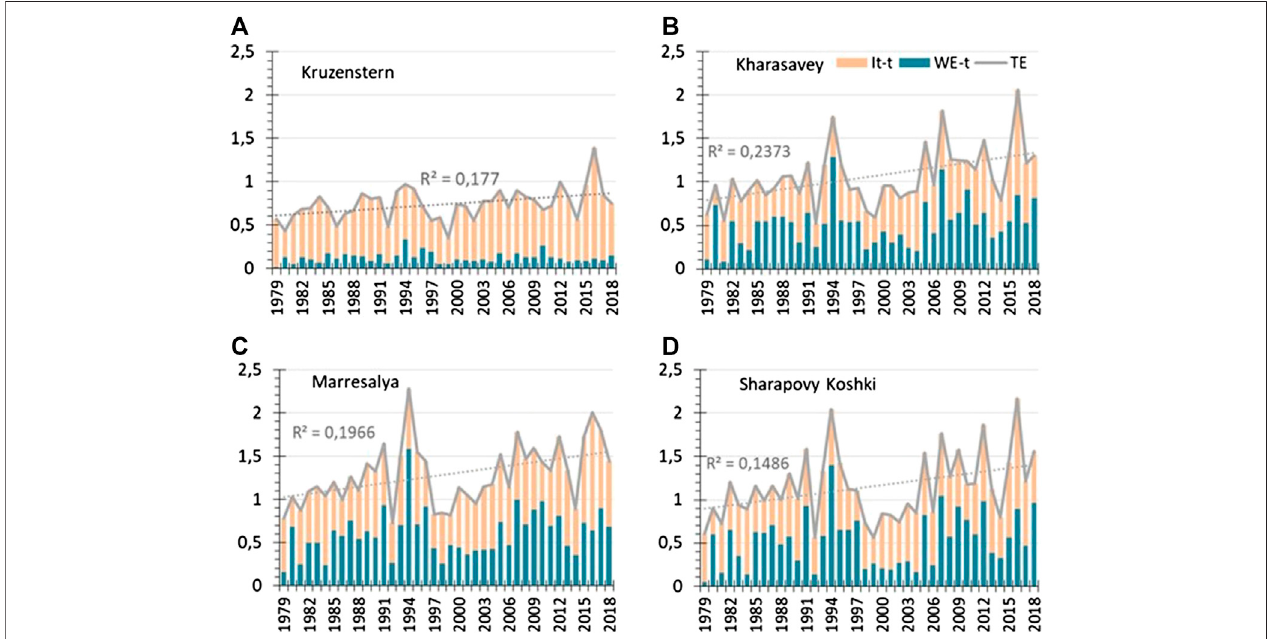
FIGURE 9 | Evolution of the normalized air thawing index ( I t ) and wind-wave energy (WE), and their total effect (TE) showing the hydrometeorological forcing of coastal erosion of the Gulf of Kruzenstern (A) , Kharasavey (B) , Marre-Sale (C) , and Sharapovy Koshki Islands (D) . The trend of the total effect is shown as a dotted line. See Figure 8D for the map of the four sites.